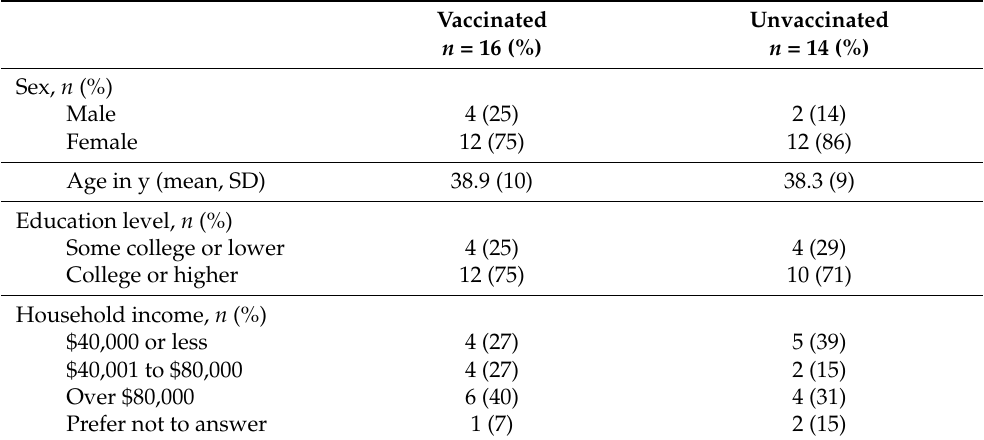
Table 1. Socio-demographic characteristics of participants by vaccination status.